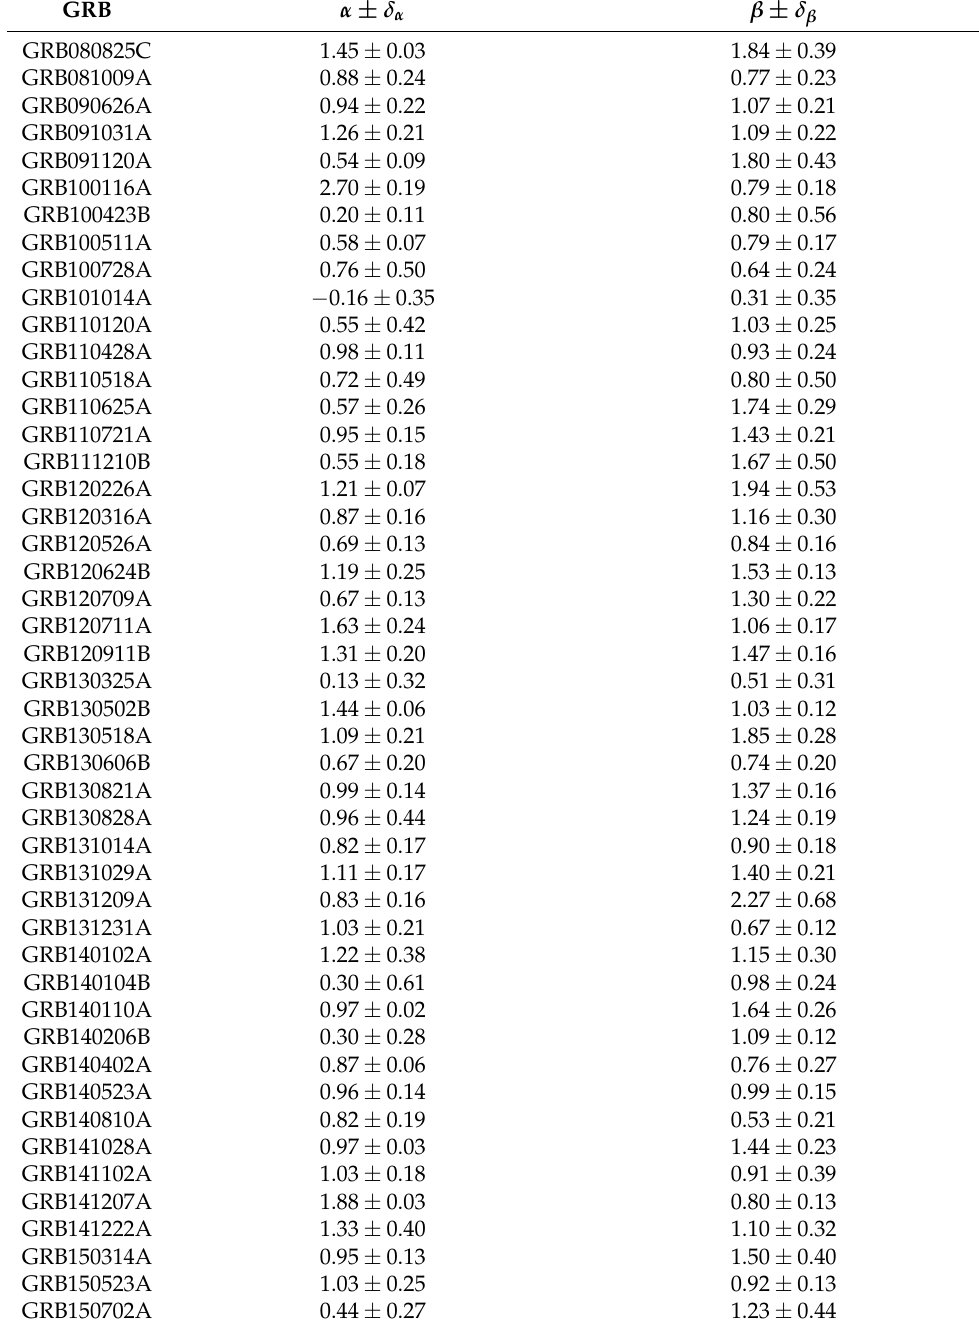
Table 1. Sample of 65 GRBs used here, fitted with a simple power law. Temporal and spectral indices are taken from Ajello et al. [8]. GRB α ± δ α β ± δ β 1.45 ±